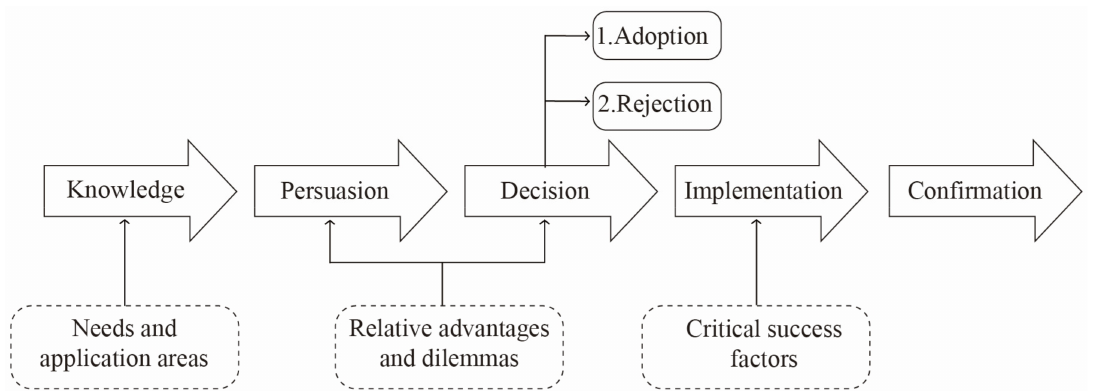
Figure 2. SVI adoption and implementation process in the built